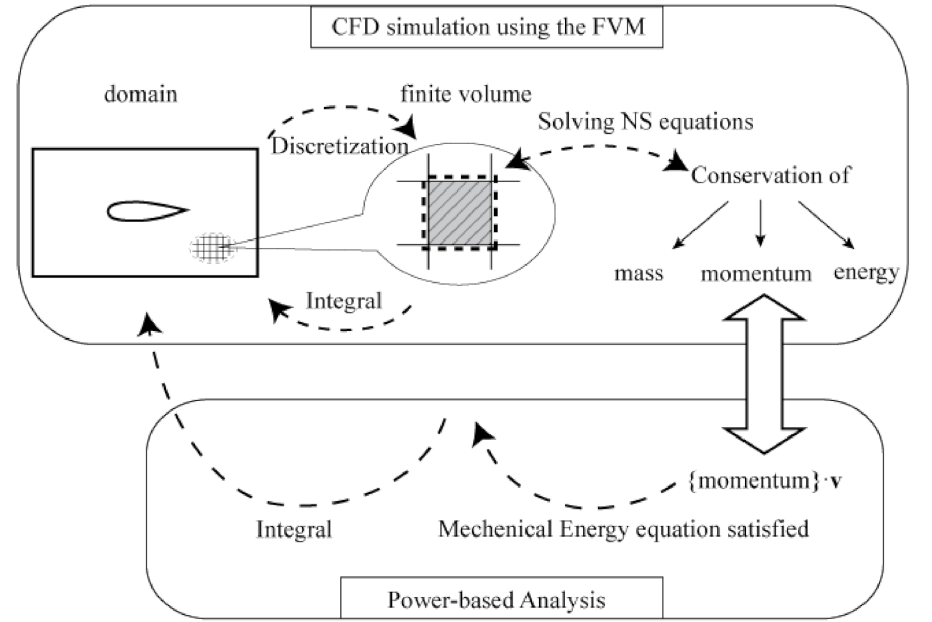
Figure 2. The diagram of power-based analysis to process the flow field of the simulation using the finite volume method